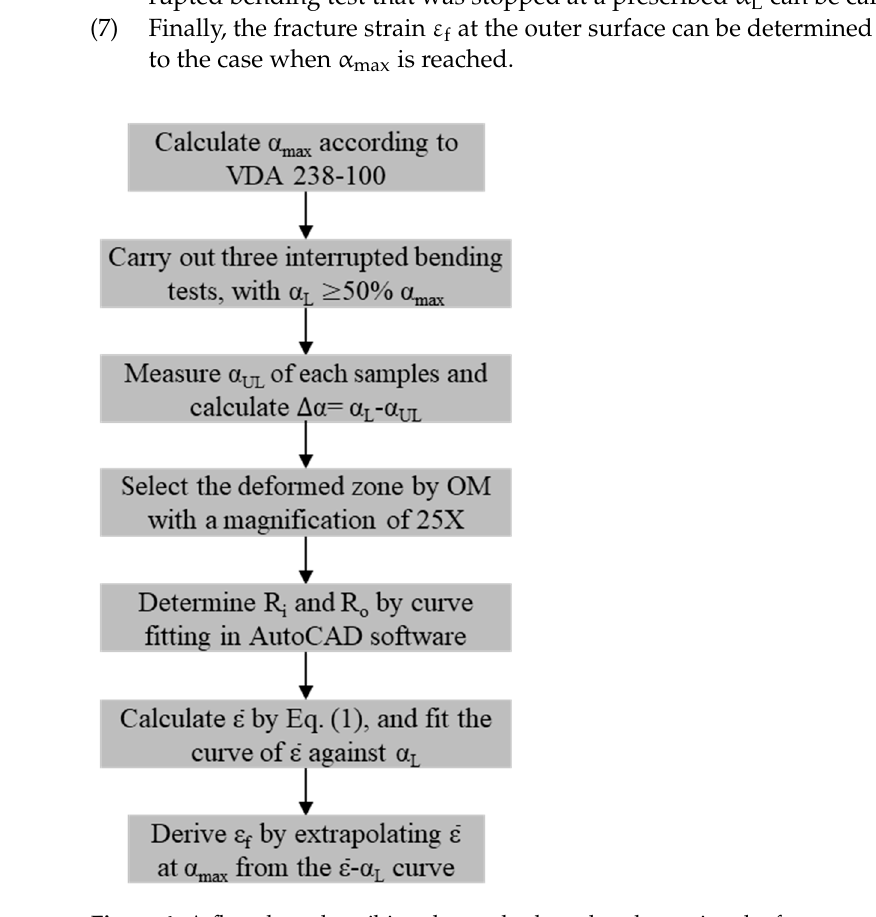
Figure 4. A flowchart describing the method used to determine the fracture strain ε f under plane-strain bending.